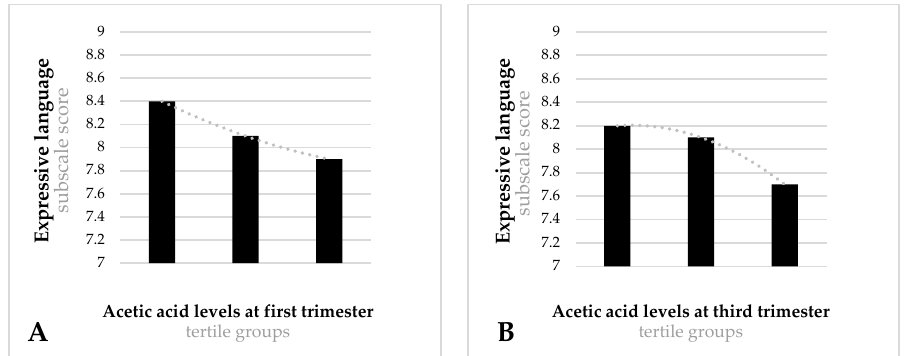
Figure 1. Expressive language subscale scores for tertile groups of acetic acid in the first ( A ) and